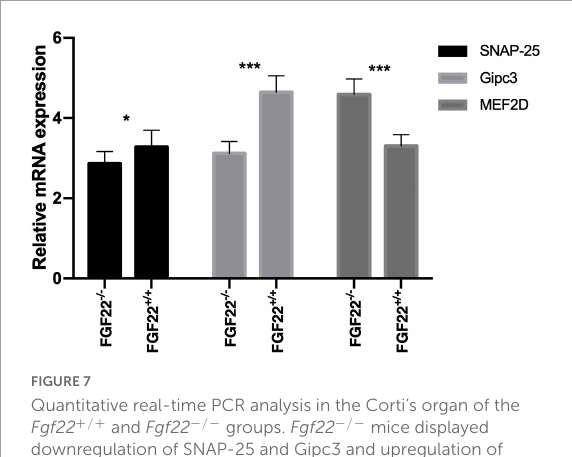
FIGURE7 Quantitative real-time PCR analysis in the Corti’s organ of the Fgf22 + / + and Fgf22 − / − groups. Fgf22 − / − mice displayed downregulation of SNAP-25 and Gipc3 and upregulation of MEF2D. Data are expressed as the mean ± SD, and statistical significance was assessed with a two-way ANOVA followed by Bonferroni post hoc test, * P < 0.05, *** P <